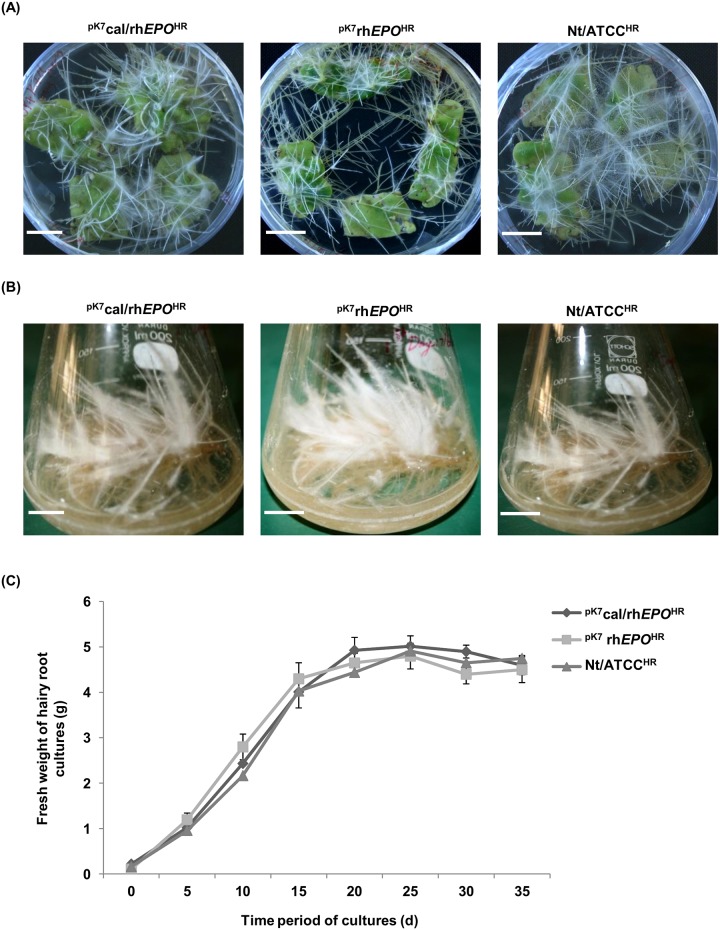
Agrobacterium rhizogenes mediated transformation and growth kinetics of the hairy root cultures.(A) Hairy root culture with cal signal sequence pK7cal/rhEPOHR, hairy root culture without cal signal sequence pK7rhEPOHR and control hairy root cultures Nt/ATCCHR were shown. Scale bars are 1 cm. (B) Establishment of the initiated hairy roots (1–2 cm) in 50 mL of liquid WPM. Scale bars are 5 cm. (C) Graphical representation of growth kinetics for the hairy root cultures. All samples were measured in triplicates and each data represents the average ± SD.